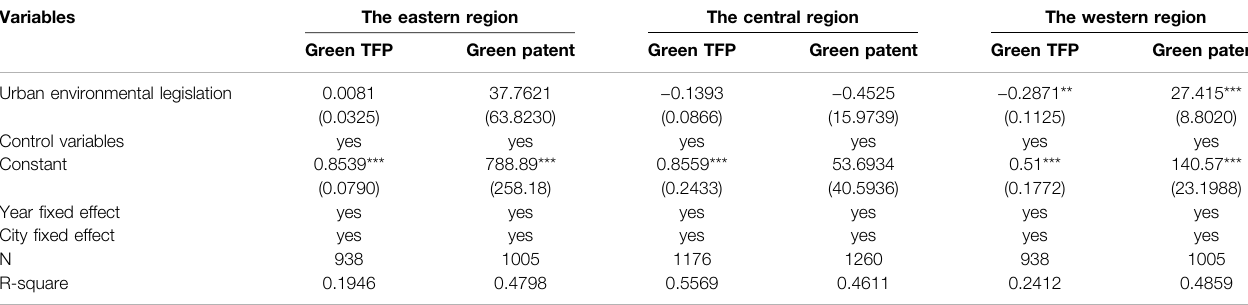
TABLE 8 | Regression results by region samples.